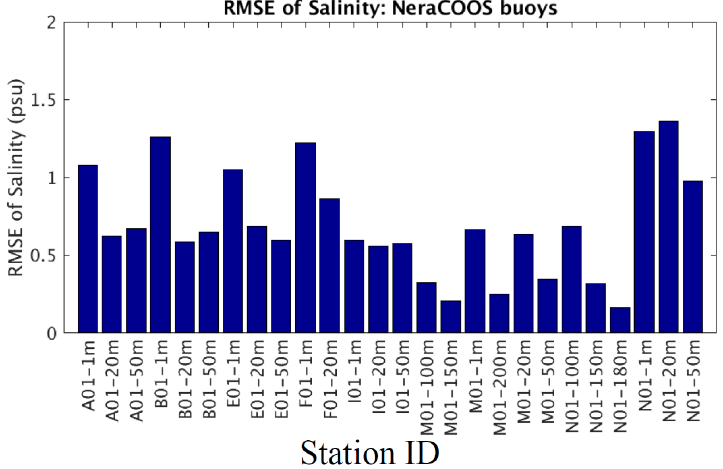
Figure 12. The RMSE of the modeled salinity.